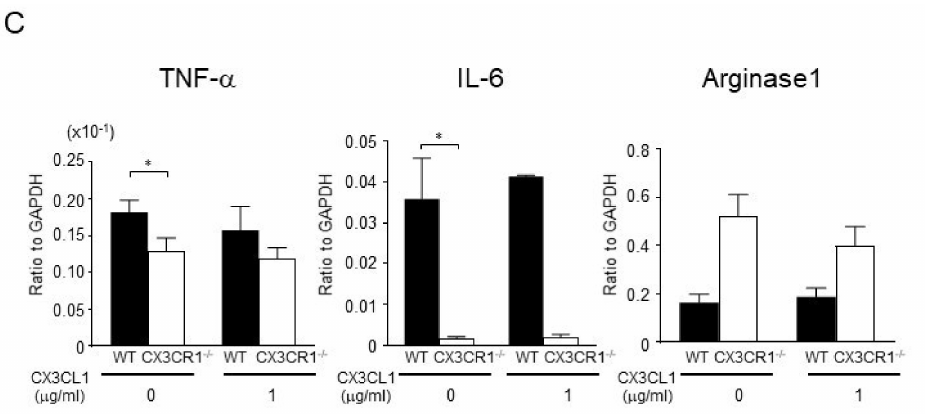
Figure 4. TNF- α and IL-6 expression was decreased and arginase-1 expression was increased in macrophages from CX3CR1 − / − mice. ( A ) Cells were collected from the skin at 48 h from DNFB challenge. TNF- α , IL-6, and arginase-1 expression from F4 / 80 + cells was assessed by intracellular flow cytometric analysis. Representative histograms comparing WT mice and CX3CR1 − / − mice. ( B ) Mean fluorescence intensities of TNF- α , IL-6, and arginase-1. All values represent the mean ± SEM. n = 3–4. Results are representative of two experiments with similar findings. * p < 0.05 by Mann–Whitney U-test. ( C ) Peritoneal macrophages from wild-type mice and CX3CR1 − / − mice were cultured with soluble CX3CL1 (0, 1 µ g / mL) for 24 h. TNF- α , IL-6, and arginase-1 mRNA expression levels were measured by real-time PCR. All values represent the mean ± SEM. n = 4. Results are representative of three experiments with similar findings. * p < 0.05 by Mann–Whitney